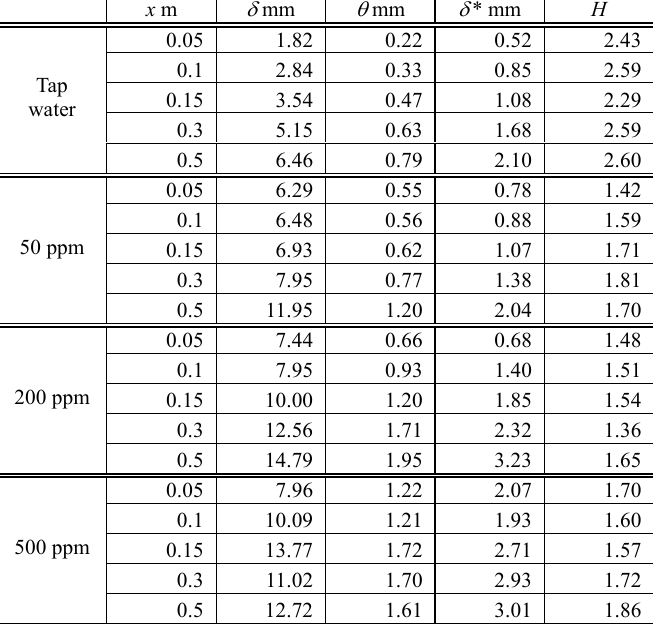
Table 1 Boundary layer